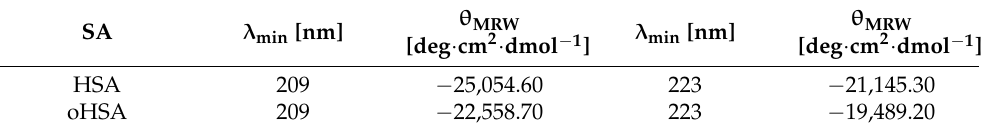
Table 3. [ Θ MRW ] at λ min for 1·10 − 6 mol·L − 1 HSA and oHSA.